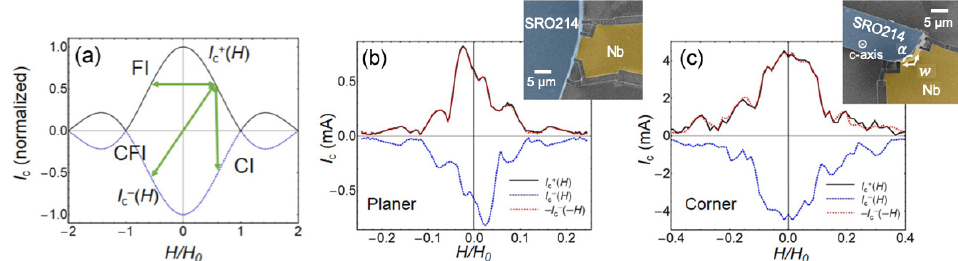
Figure 5. ( a ) Critical current vs. normalised magnetic field ( I c ( H / H 0 ) ) showing three types of symmetries; including, current inversion (CI), magnetic field inversion (FI), and current and magnetic field inversion (CFI). ( b , c ) I c ( H ) measurements for planner ( T = 0.31 K, w = 7.1 µ m) and corner ( T = 0.32 K, w = 10 (5 + 5) µ m, α = 2/3 π ) junctions. Consistency between I + c ( H ) (black) and − I − c ( − H ) (red) curves indicates that the critical current in both junctions exhibits CFI symmetry. It supports the time-reversal invariance of superconductivity in SRO214. False-colour scanning ion micrographs of the junctions are shown in the insets. (Adopted with permission from [72] copyright APS